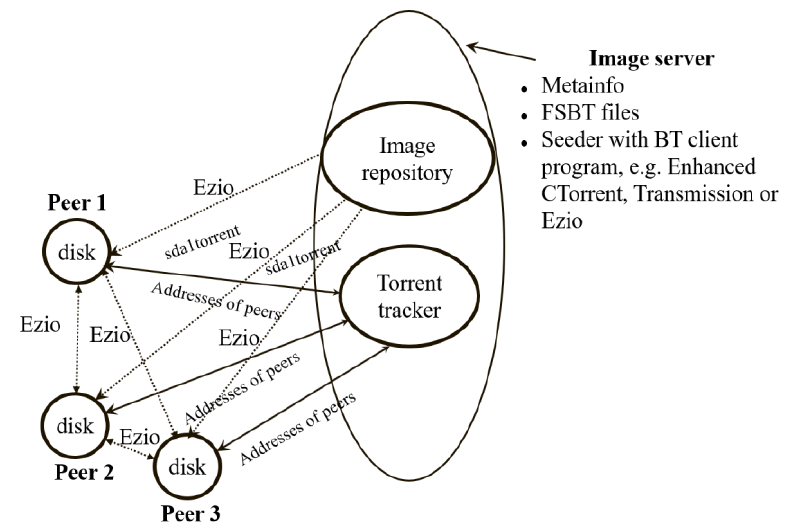
Figure 8. The BT solution for massive system deployment.